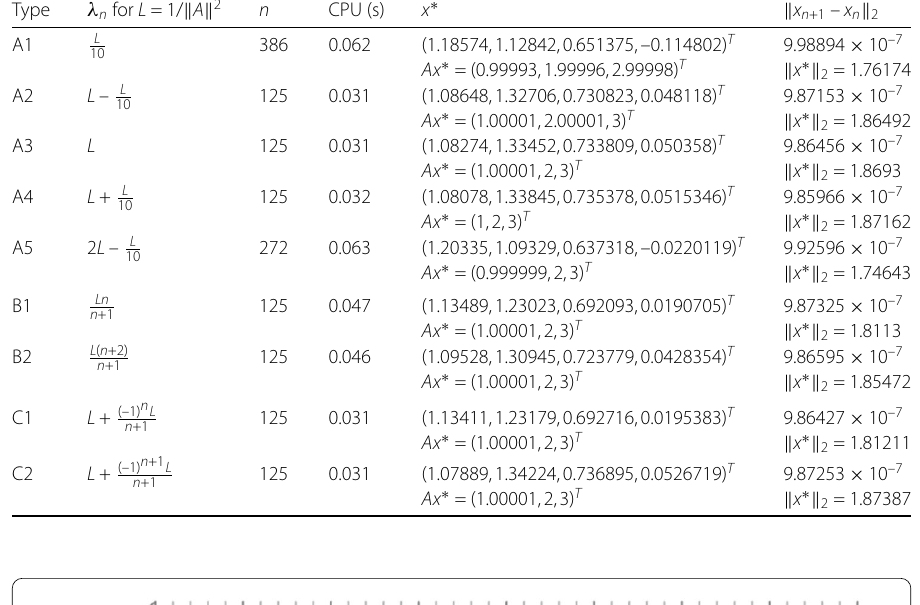
Table 4 Numerical results of Example 4.10 for the initial points x 0 = (1,1,0,2) T and x 1 = (2,1,3,0) T using the algorithm in Theorem 4.9